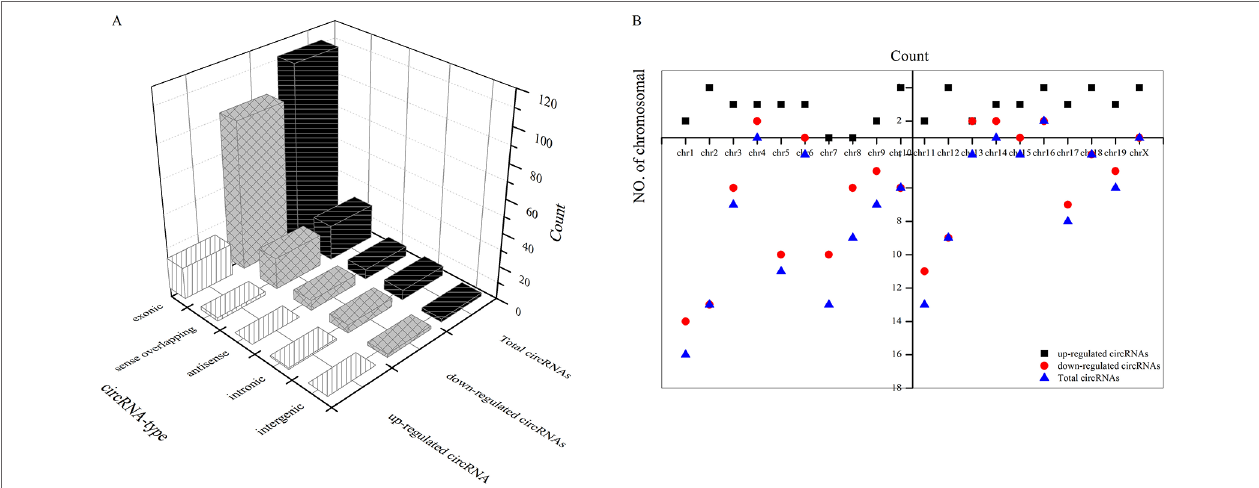
FIGURE 5 | Types of differential circRNAs and their distribution on chromosomes. (A) types of differential circRNAs, (B) circRNAs distribution on